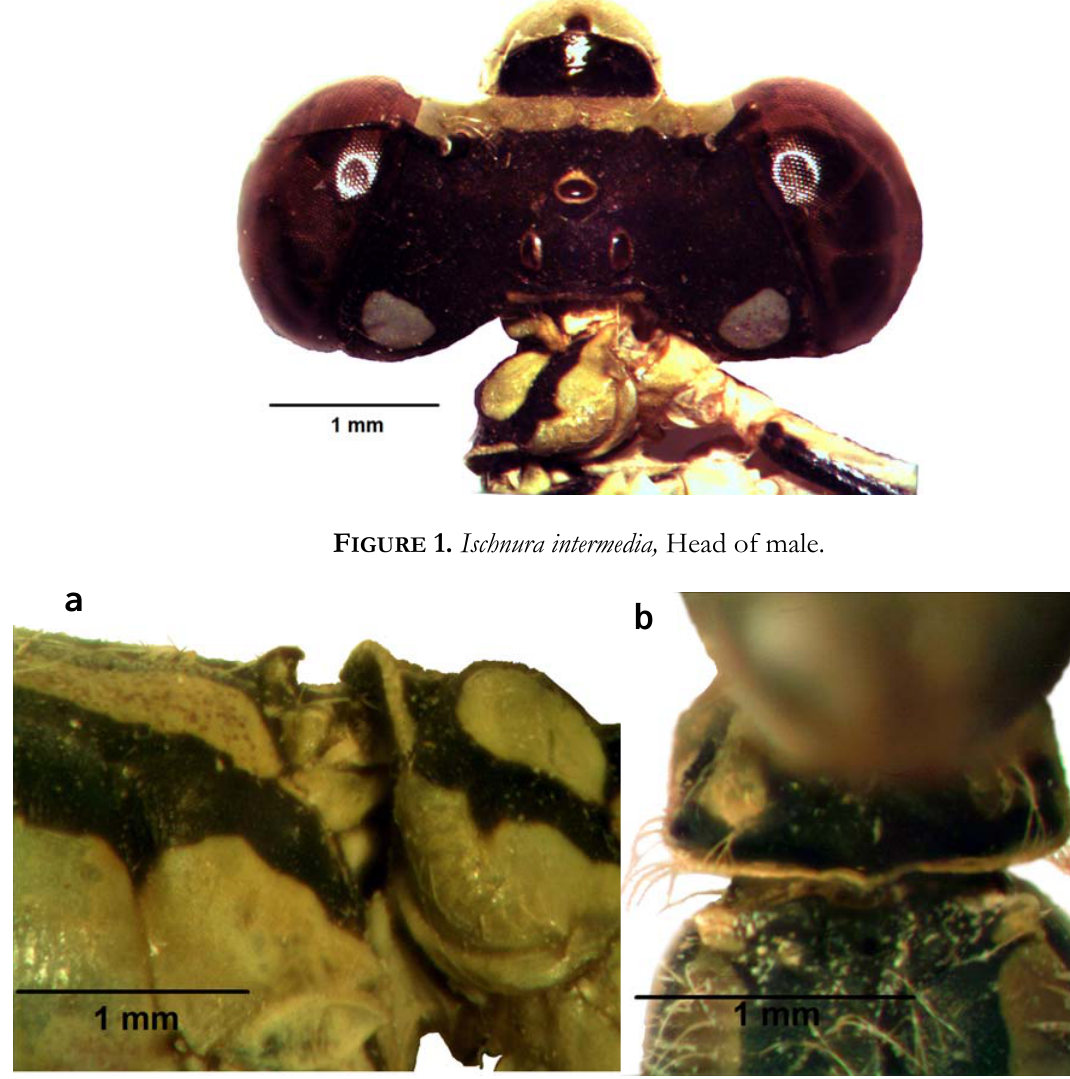
F IGURE 2. Ischnura intermedia , male, pronotum, lateral view (a), Dorsal view (b) Abdomen: dorsal parts of S1-S7 jet-black, with triangular shape near to posterior border of